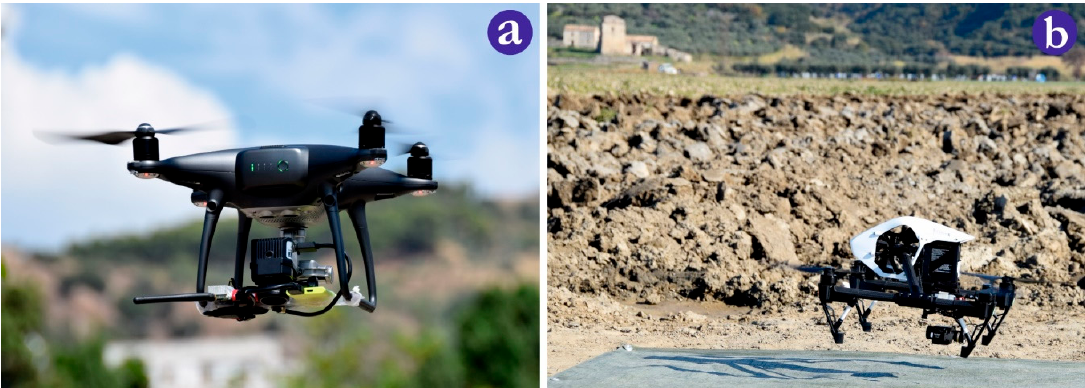
Figure 3. DJI Phantom 4 pro ( a ) and ( b ) DJI Inspire 1, both equipped with a FLIR uncooled thermal camera (photos taken by the authors).